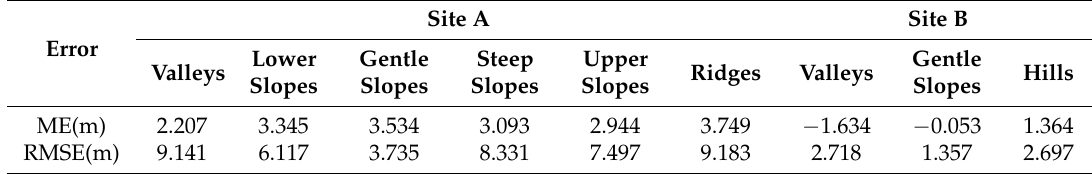
Table 4. Statistical measures of elevation errors for different slope position classes.